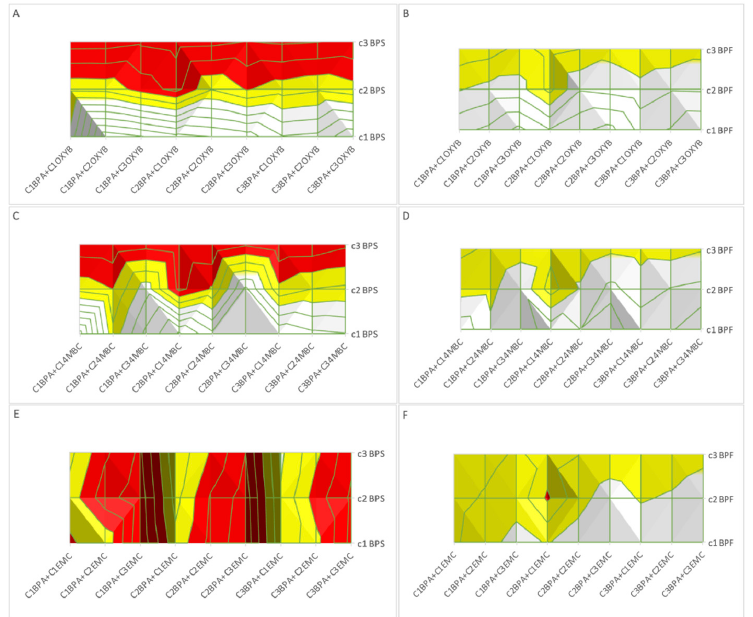
Figure 1. MDR values of Aliivibrio fischeri bioluminescent bacteria results for: ( A ) CA modeling of the BPA, OXYB and BPS mixture, ( B ) CA modeling of the BPA, OXYB and BPF mixture, ( C ) CA modeling of the BPA, 4MBC and BPS mixture, ( D ) CA modeling of the BPA, 4MBC and BPF mixture, ( E ) CA modeling of the BPA, EMC and BPS mixture, ( F ) CA modeling of the BPA, EMC and BPF mixture ( n = 2). Red color indicates confirmed synergy, blue indicates antagonism, while yellow and green refer to under- and overestimation, respectively.